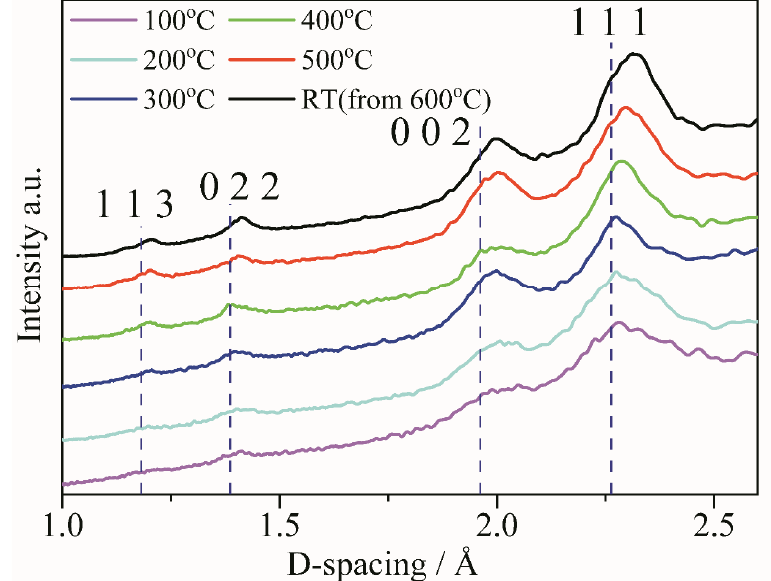
Figure 6. The structural evolution of the Pt interconnector with temperature in real-space obtained from the serial FFT patterns from HREM images at different temperatures.